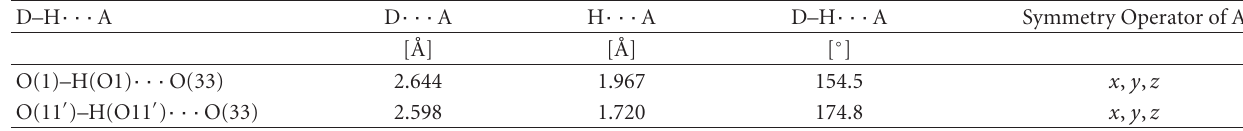
Table 3: Dimensions of the hydrogen bonds in complex 1 · (py)C(Me)NOH . a